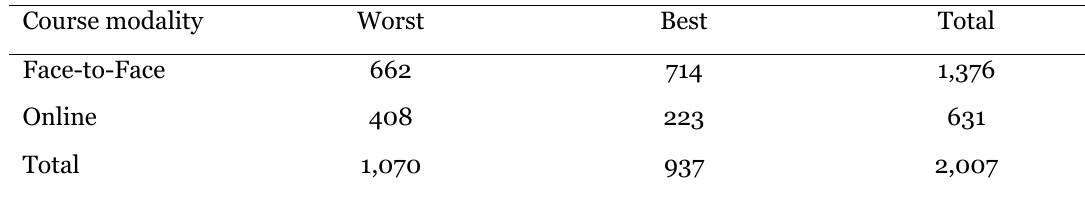
Student Respondent N by Course Designation and Modality